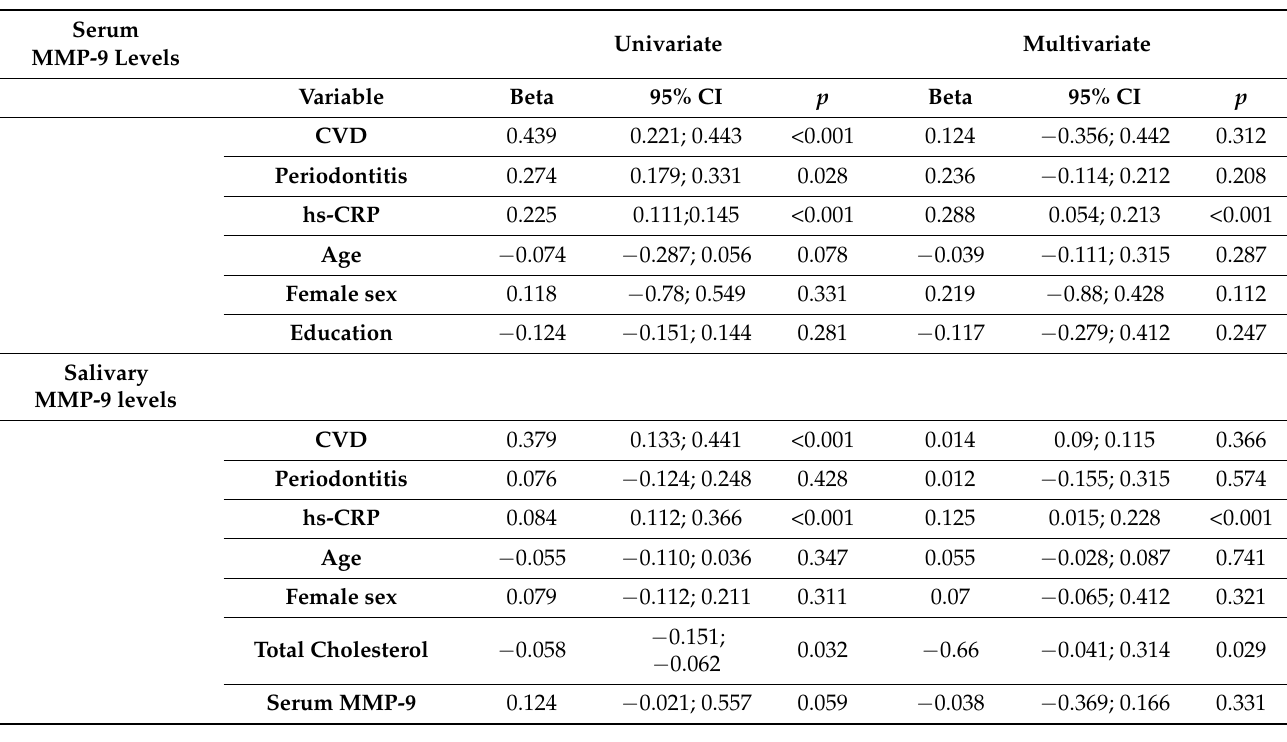
Table 3. Linear regression models that analyzed serum and salivary MMP-9